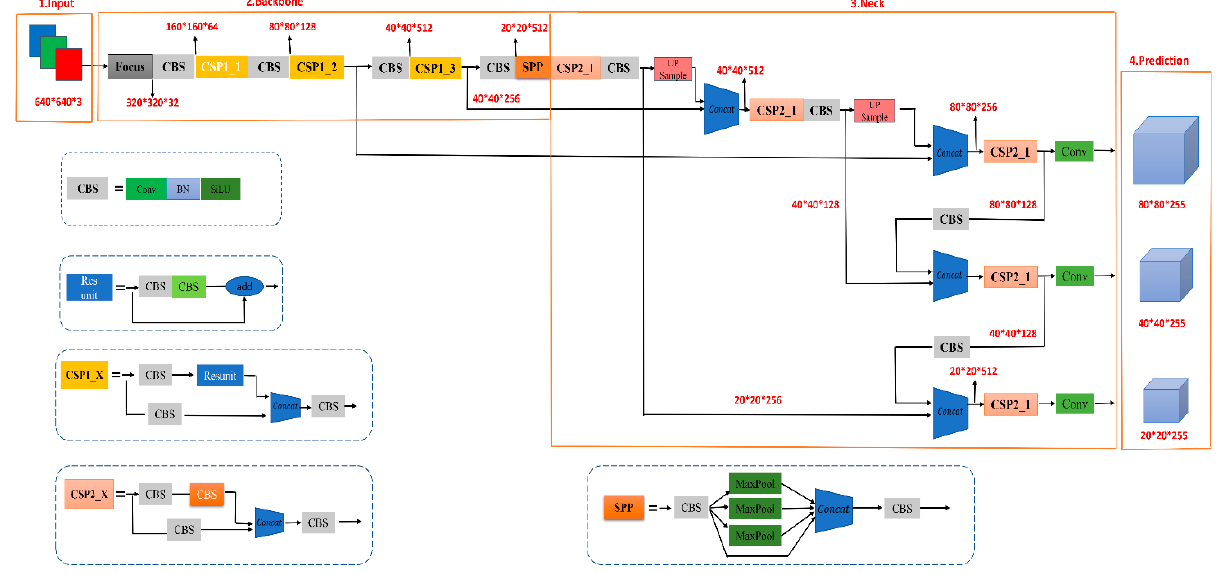
Figure 1. Focus slicing process.